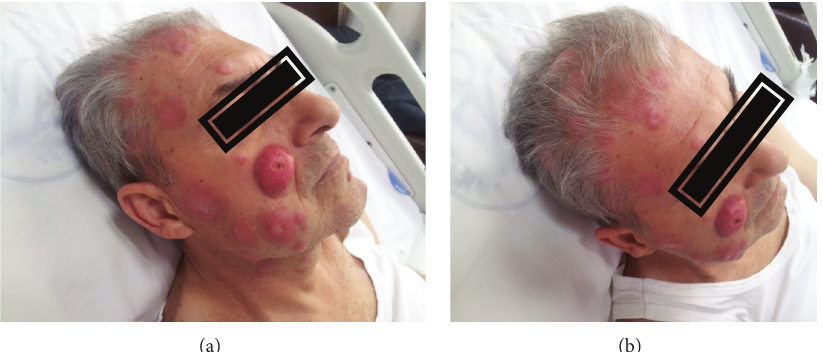
Figure 4: Progression of Her-2 negative skin metastases after 6th cycle of chemotherapy. (a) Face and (b)